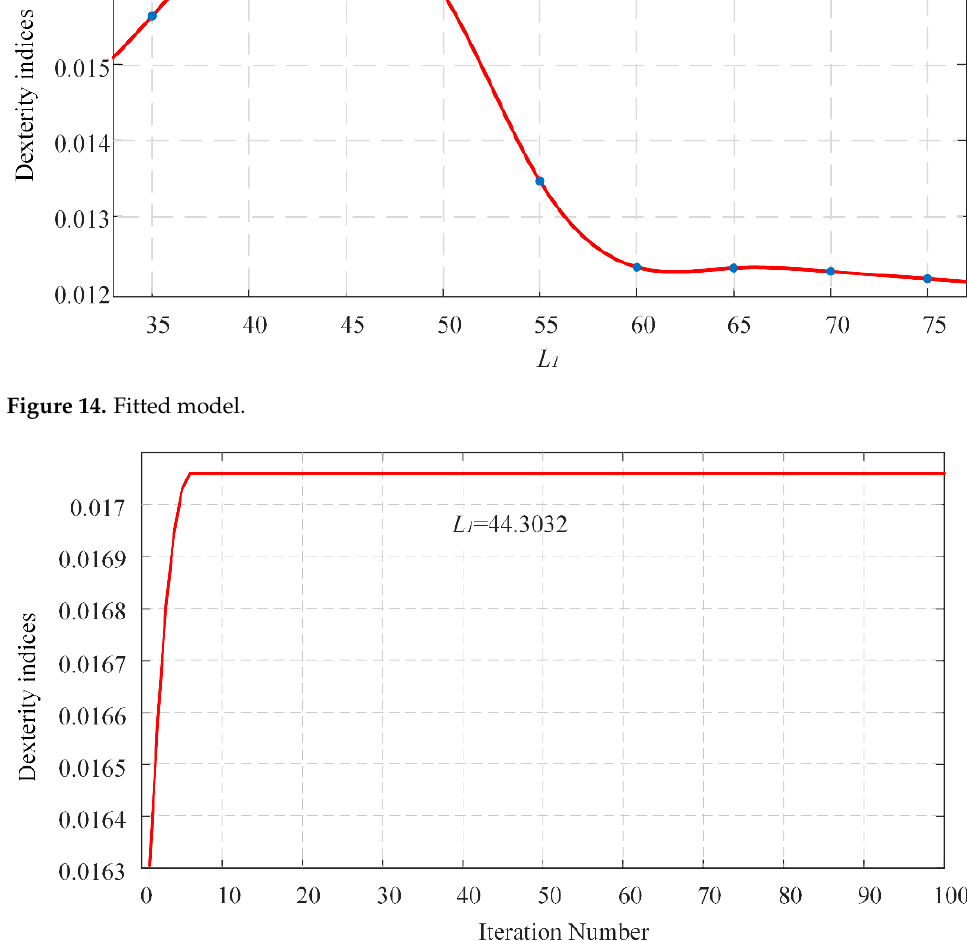
Figure 15. FOA-based dexterity index optimization.